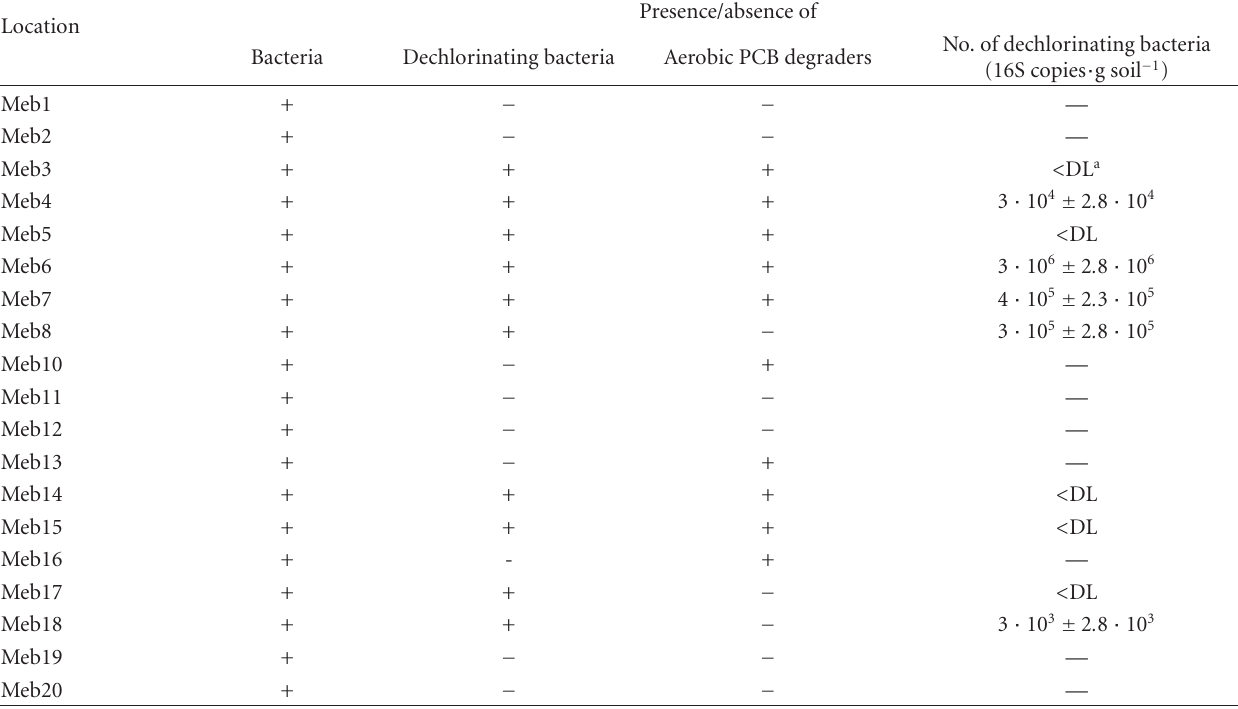
Table 2: Analyses of total bacteria, putative PCB dechlorinating and PCB degrading bacteria and the number of putative dechlorinating bacteria in soil samples. Sample Meb9 was not